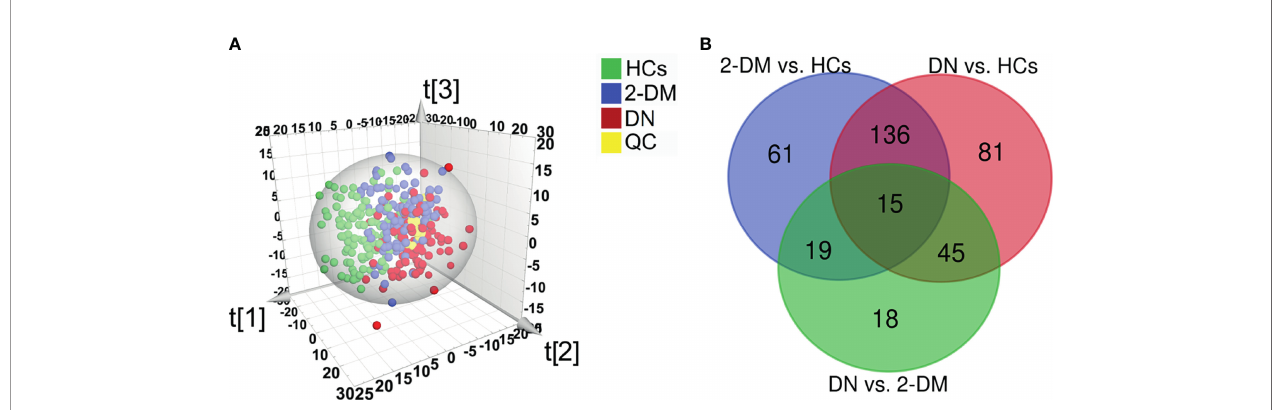
FIGURE 2 | Identi fi cation of potential metabolic biomarkers for the diagnosis of DN. (A) Partial least squares-discriminant analysis (PLS-DA) score plot based on HCs (green), 2-DM (blue), DN (red) groups, and QC samples (yellow) in the Discovery Set. (B) Venn diagram displays the differential metabolites when the 2-DM and DN groups were compared with the HCs, and the DN groups was compared with the 2-DM in the